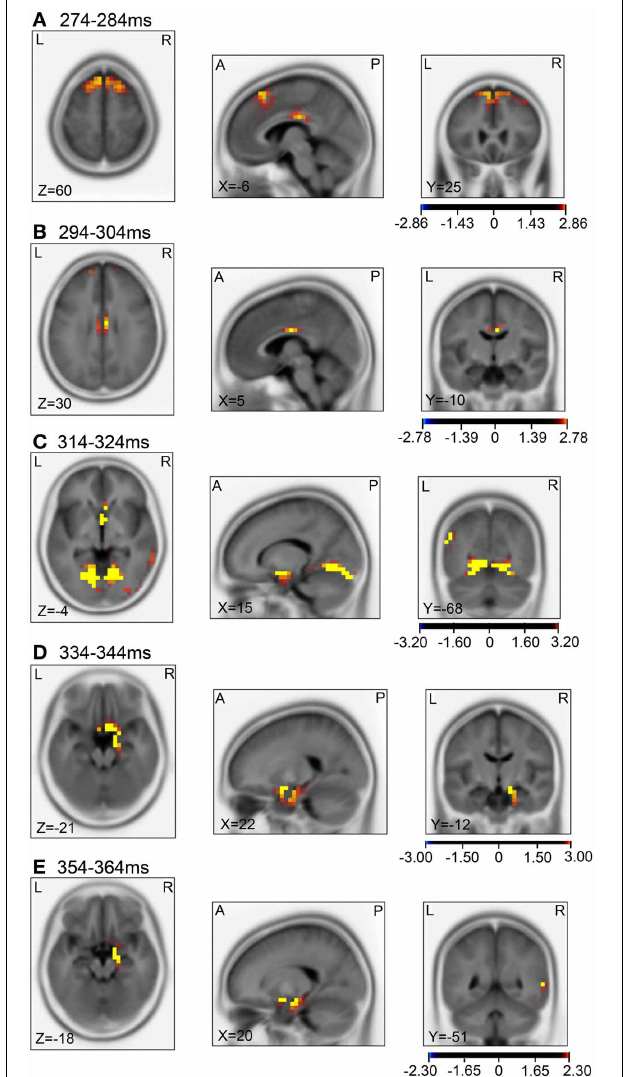
FIGURE 10 | sLORETA statistical nonparametric maps comparing the current source density between the ERPs in the baseline and the test phase in the 5 time windows, 274–284ms (A), 294–304ms (B), 314–324ms (C), 334–344ms (D), 354–364ms (E), shown in Figure 9A.